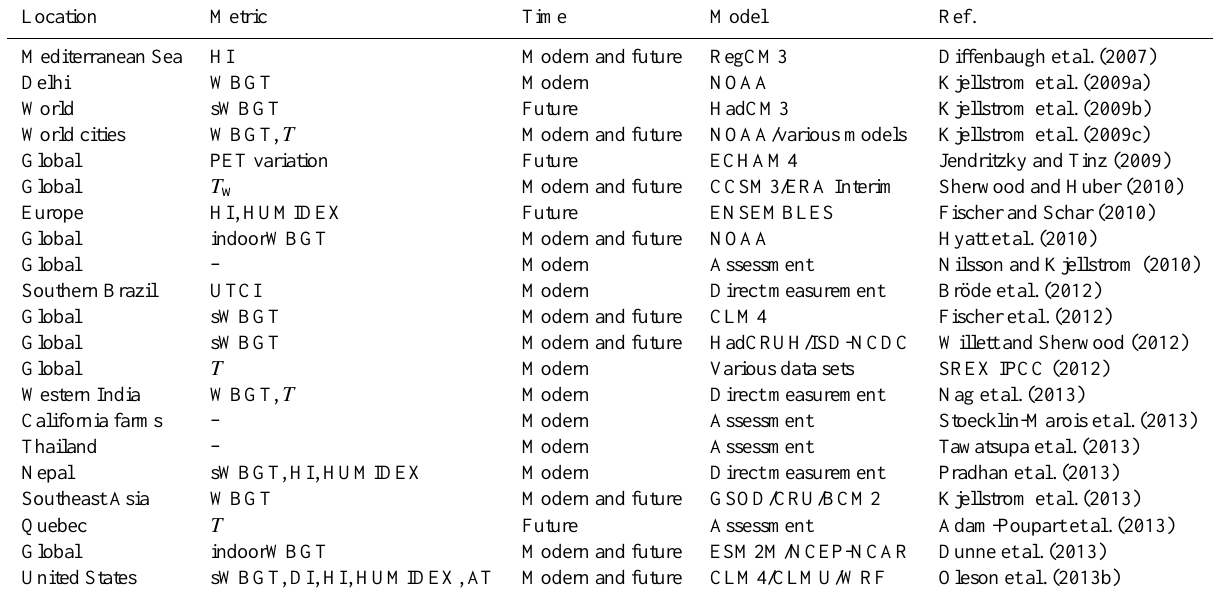
Table 3. List of previous heat stress studies. Studies using data sets, reanalysis, and/or model output that range from ∼ 1900 until ∼ 2010 are labeled “modern” and from ∼ 2005 to ∼ 2100 are labeled “future”. Some studies do not analyze heat stress quantitatively